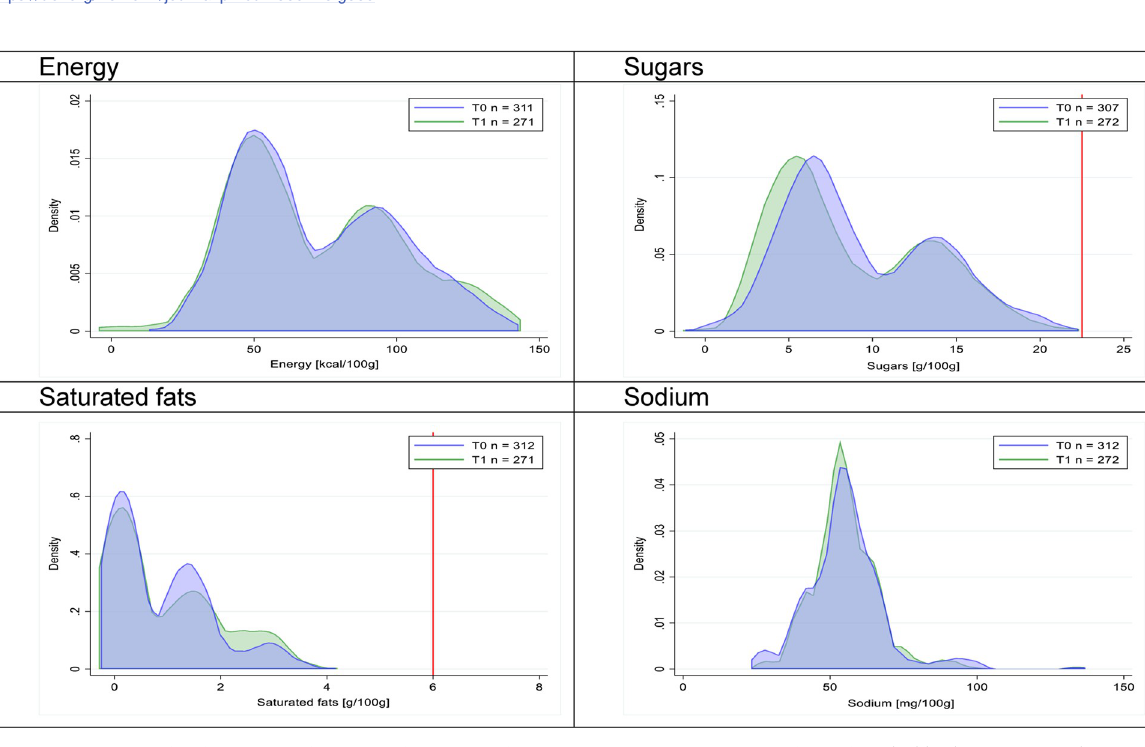
Fig 4. Density curves for the amount of energy and nutrients of concern in yogurts, cross-sectional samples. The blue line represents the distribution in T0 (preimplementation), the green line represents the distribution in T1 (postimplementation), and the red line represents the cutoff for the amount of energy or nutrients of